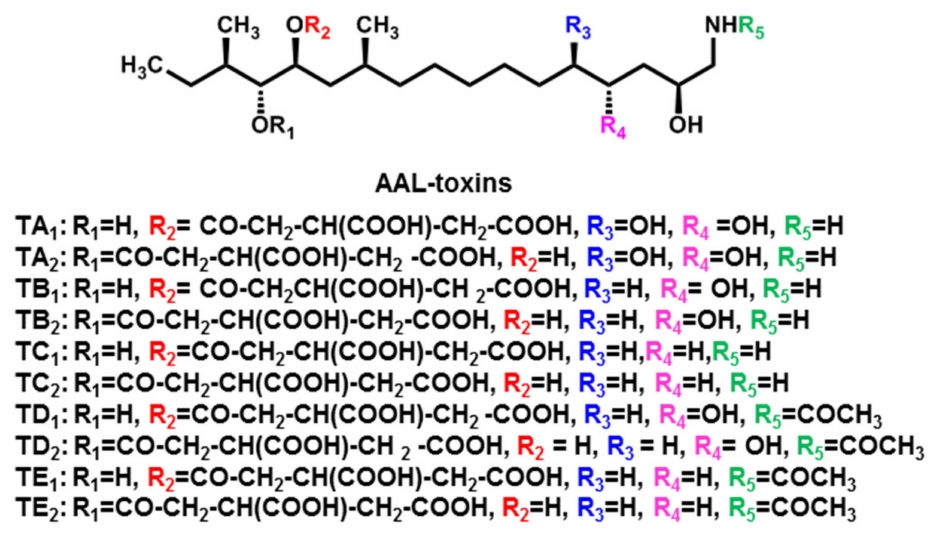
Figure 2. Chemical structures of